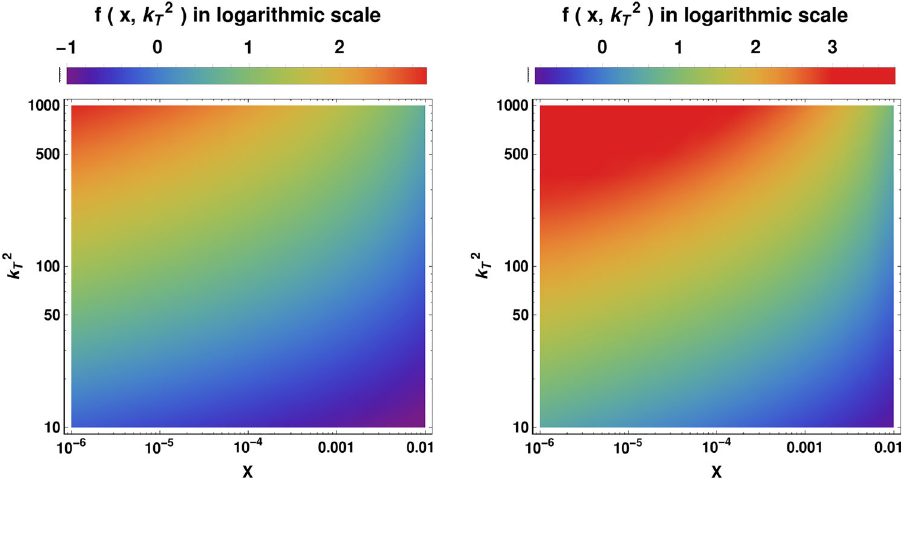
Fig. 11 Density plots showing R sensitivity of unintegrated gluon distribution f ( x , k 2 sketched for two form of shadowing: conventional R = 5 GeV − 1 (left) and extreme R = 2 GeV − 1